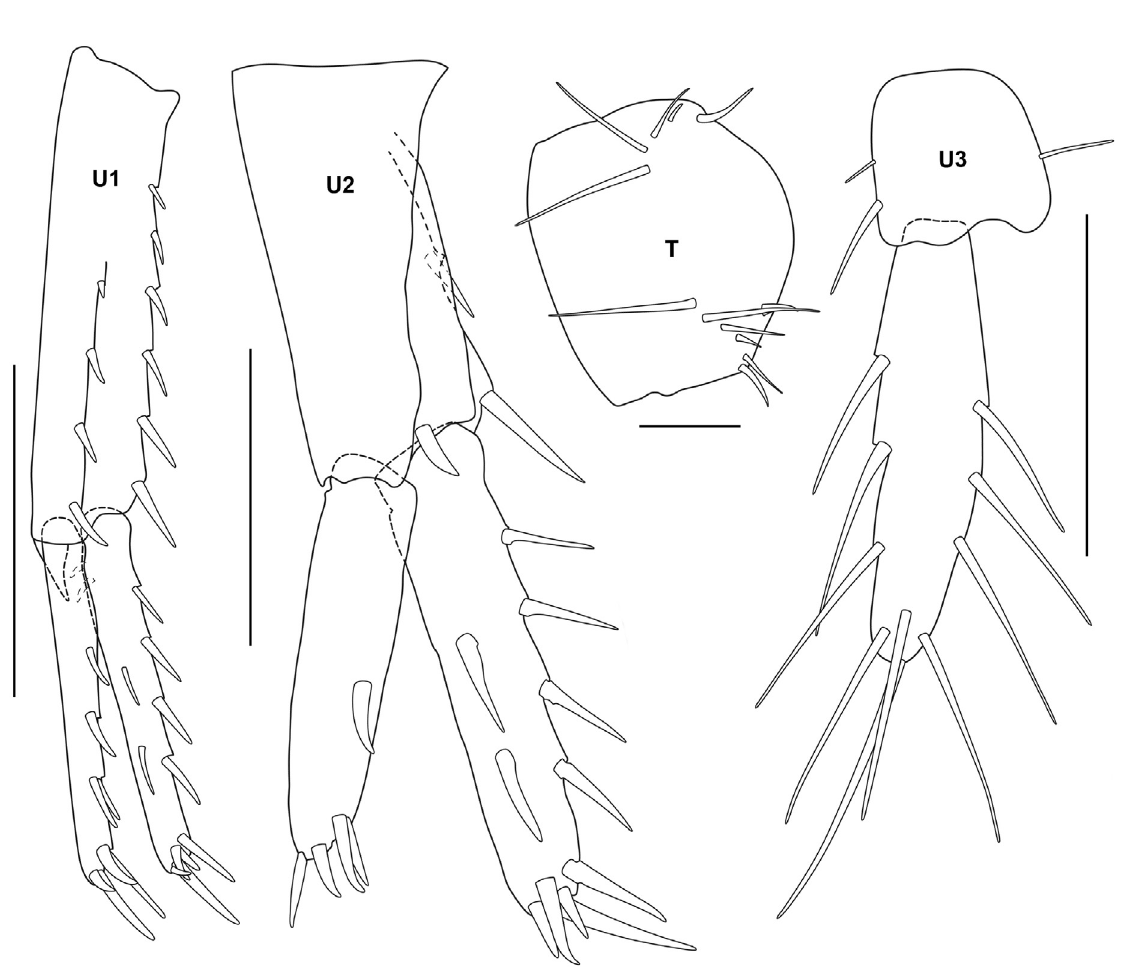
Fig. 15. Grandidierella sungeicina sp. nov., holotype, ♂ (ZRC 2018.0490). Scale bars: T = 0.1 mm; U1 = 0.5 mm; remaining scales = 0.25